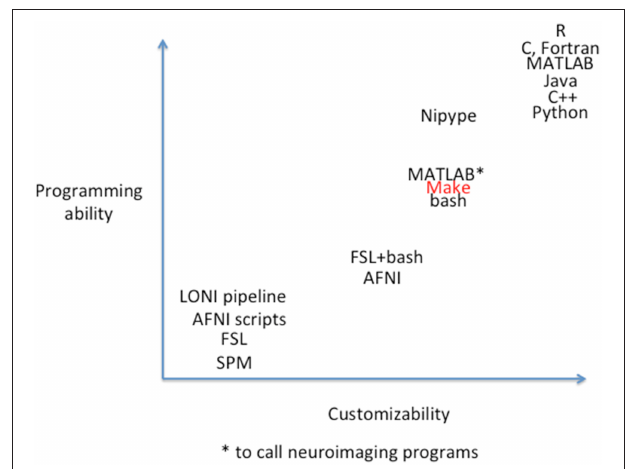
FIGURE 1 | Conceptual two dimensional space of pipeline tools. In one dimension is customizability; how possible is it to modify the pipeline to include new neuroimaging processing algorithms? In the second dimension is programming ability. How much programming skill does it take to modify the pipeline? Relative programming ability is estimated based on our collective lab experience and current salaries for skills, where available ( Dice.com., 2015). Customizability is estimated based on our lab